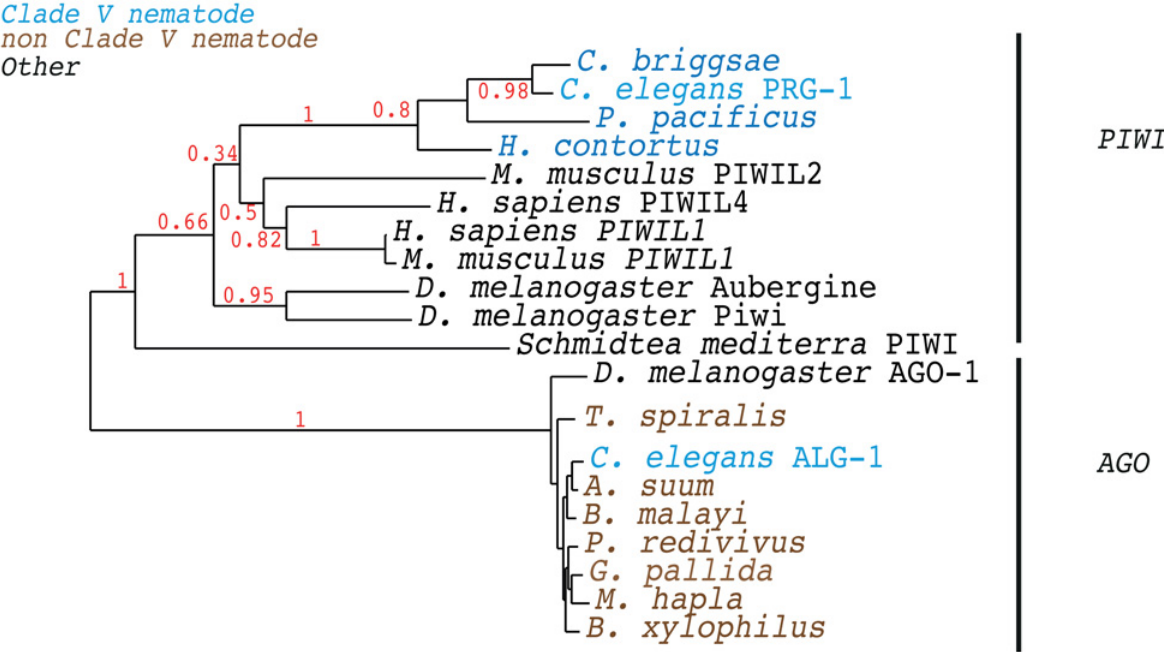
Fig 5. Loss of the Piwi protein in nematodes outside of clade V. Maximum likelihood phylogenetic tree of the best homologues of D . melanogaster Piwi found in the analysed nematode genomes. We included a subset of known Piwi proteins and Ago proteins from other organisms for comparison. The alignment is in S1 Data. Bootstrap branch support values from 100 bootstraps are shown. The tree file is in S4 Data.